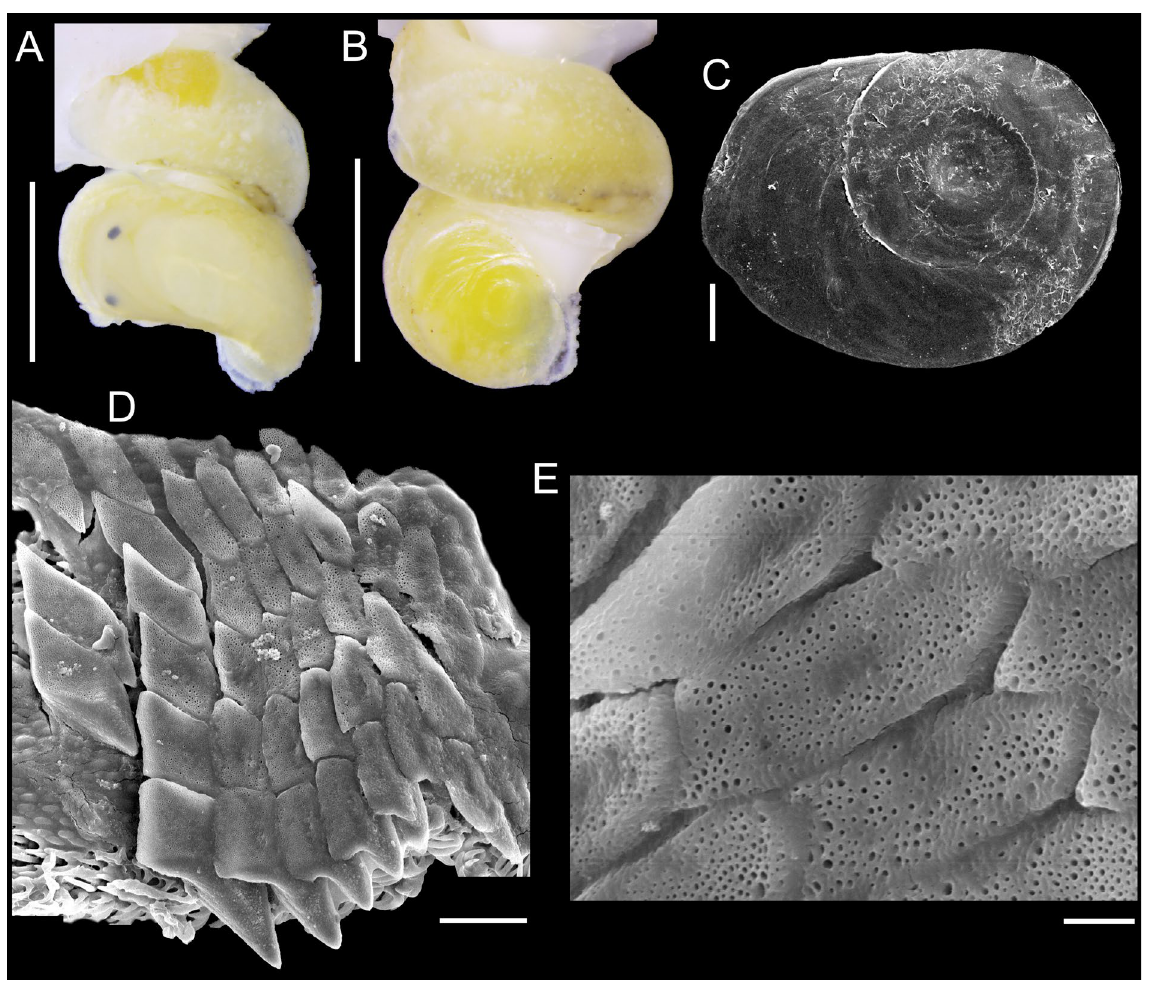
Fig. 28. Strobiligera gaesona (Dall, 1927). A–E . MZSP 53697. A–B . External morphology. C . Operculum. D–E . Jaw, outer side. Scale bars: A–B = 1 mm; C = 100 µm; D = 10 µm; E = 2